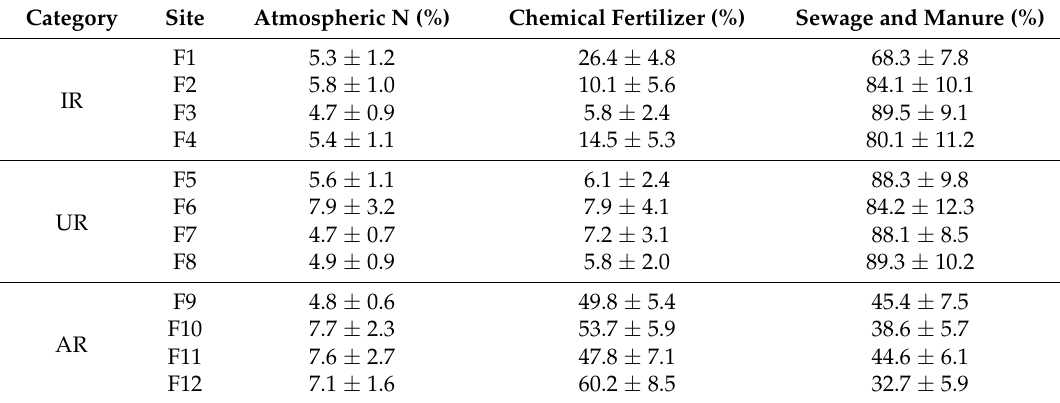
Table 2. Proportional contributions of three potential nitrate sources as estimated using IsoSource model in the lower reach of Fenhe